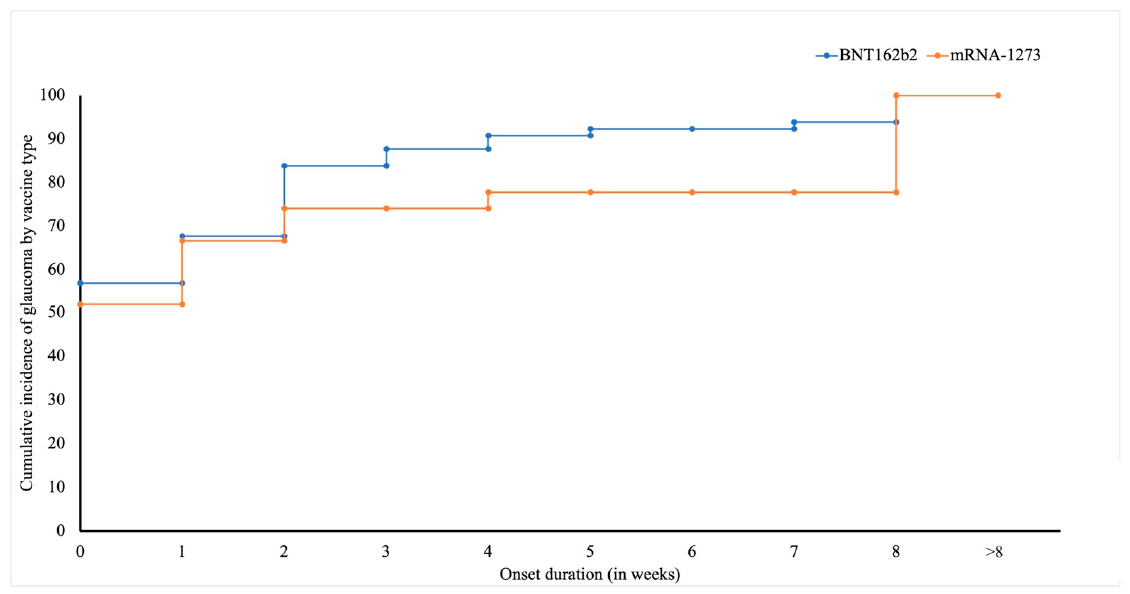
Figure 2. Cases of glaucoma post-vaccination with protocol doses (Doses 1 and 2 for BNT162b2 and mRNA-1273 and Dose 1 for Ad26.COV2.S) and boosters.